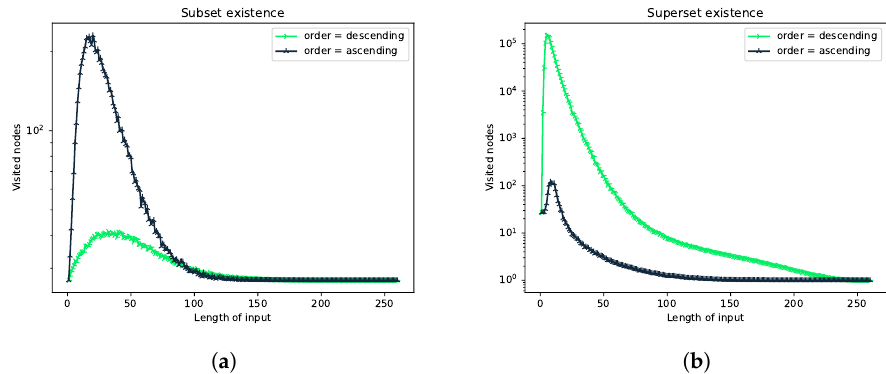
Figure 9. Existence functions in Experiment 4. ( a ) submsetExistence; ( b ) supermsetExistence.